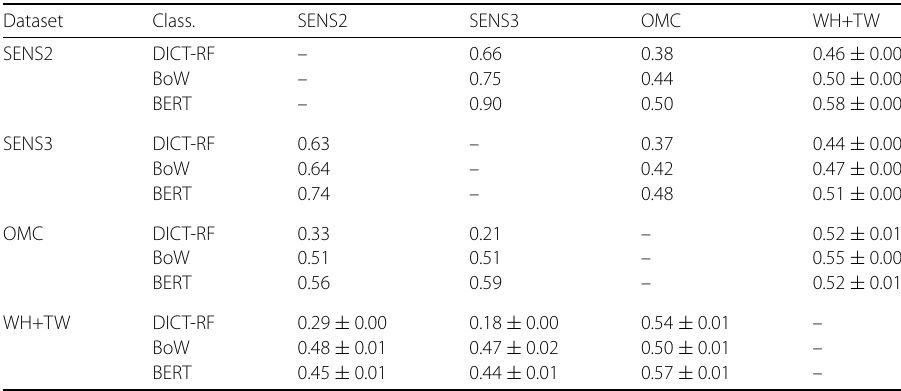
Table 18 Cross-classification results (macro-averaged F1-scores). Classifiers are trained on the datasets reported in the row, and tested on the datasets reported in the columns Dataset Class. SENS2 SENS3 OMC WH+TW SENS2 DICT-RF – 0.66 0.38 0.46 ± 0.00 BoW – 0.75 0.44 0.50 ± 0.00 BERT – 0.90 0.50 0.58 ± 0.00 SENS3 DICT-RF 0.63 0.37 0.44 ± 0.00